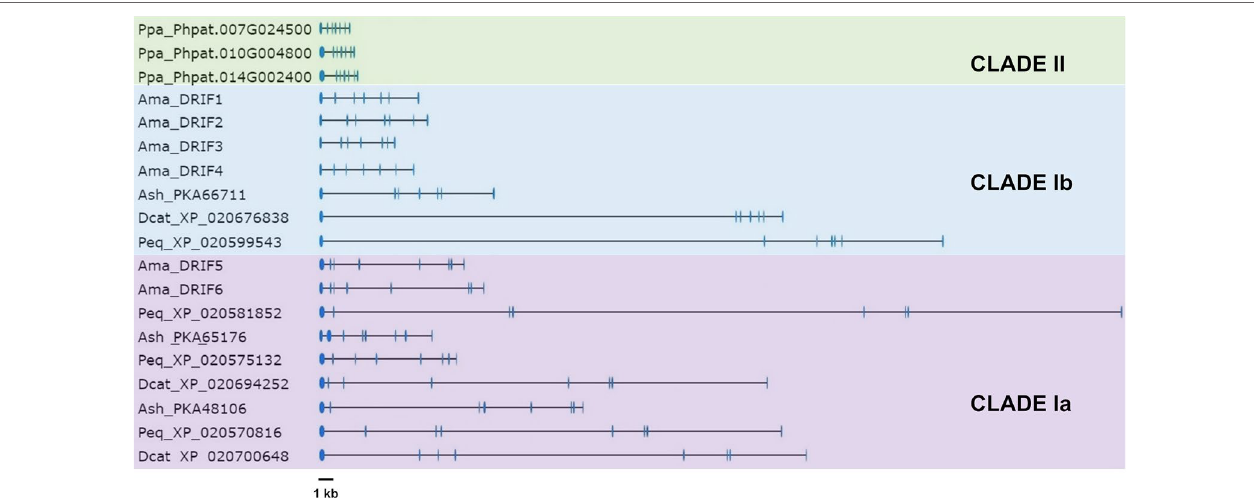
FIgURE 3 | Genomic organization of the DRIF genes of Phalaenopsis equestris , Dendrobium catenatum , Apostasia shenzenica (Orchidaceae), Antirrhinum majus (Lamiales), and Physcomitrella patens (Bryophyta). Light blue boxes and black lines represent exons and introns, respectively. Ama, A. majus ; Ash, A. shenzenica ; Dcat, D. catenatum ; Peq, P. equestris ; Ppa, P. patens . Clades Ia, Ib, and II are referred to the main groups detected in the DRIF phylogeny (see figure). The code number following the abbreviation of the species name is the accession number of the DRIF sequences deposited in public databases ( Table S1 ).